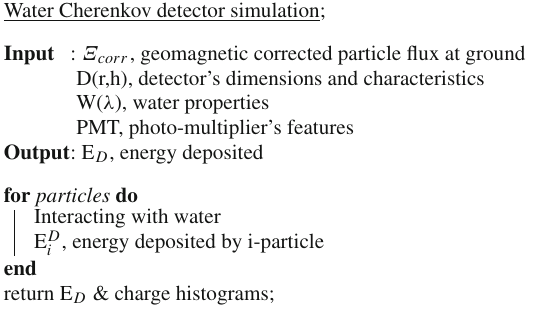
Algorithm 1: ARTI is divided in three consecutive stages: flux calculations, atmospheric model and geomagnetic con- ditions to simulate EAS developments via Corsika; geo- magnetic secular variations and disturbances via Magneto- Cosmics and their impact on the particle flux at ground; and the detector simulation via